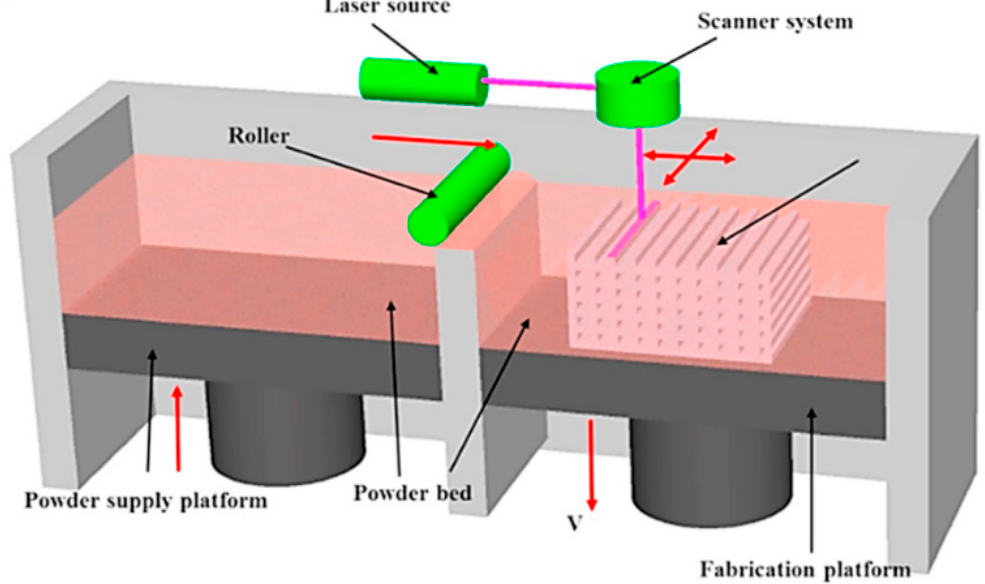
Figure 4. Schematic illustration of powder-bed fusion (reprinted with the permission from [34], Elsevier, 2018).